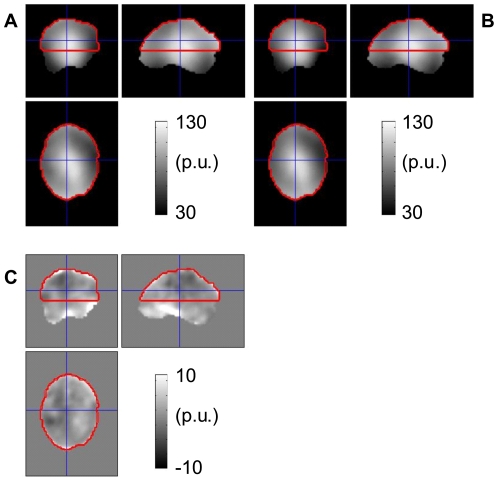
Comparison of 3D EPI and AFI methods.B1
+ maps acquired with the 3D EPI (a) and AFI (b) methods. Difference between the B1
+ maps acquired using the two methods (c). The red contour lines represent the superior part of the brain, used as a region of interest for quantitative comparison of both methods. Note that due to imperfect spoiling, the AFI method is expected to underperform in regions with low B1
+ amplitudes such as the temporal lobes.